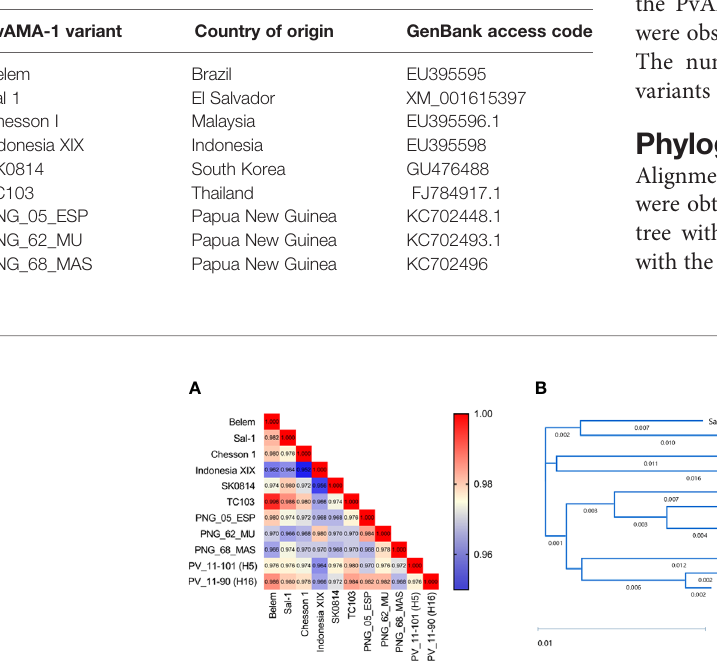
TABLE 1 | Worldwide distribution of the 9 PvAMA-1 variants.